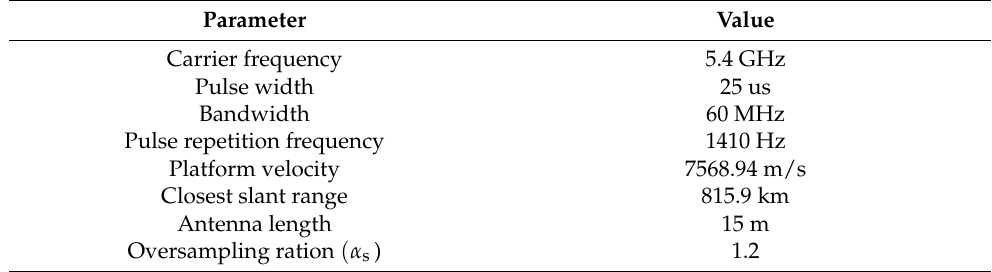
Table 1. The main parameters of the simulation.